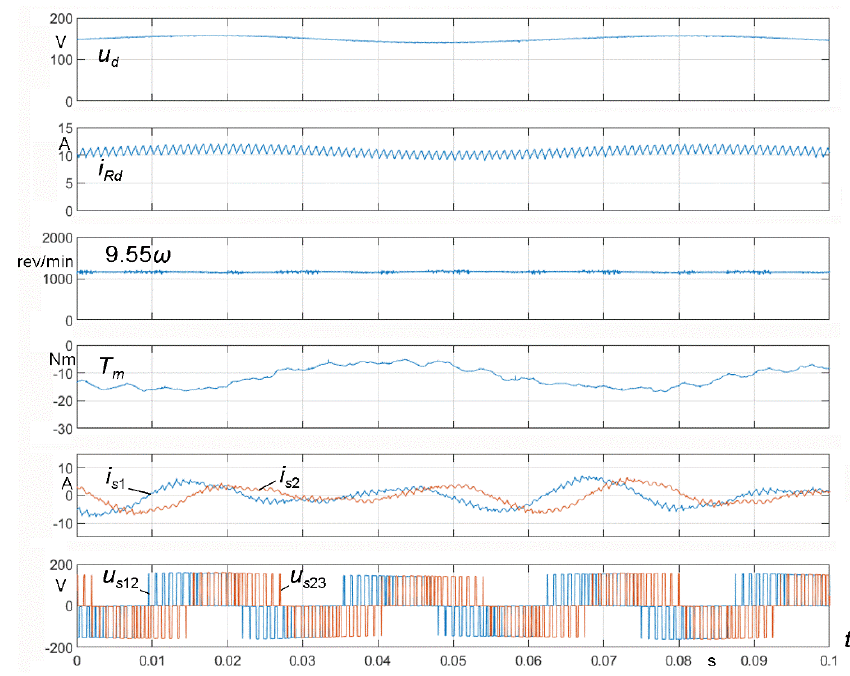
Figure 17. Steady-state waveforms corresponding to case D in Figure 13 at Ω pu = 0.6, m = 2. The work for cases A, B, and C was stable, as the voltage was kept at the set level. The torque T m showed a slight undulation. For A and B, the phase currents were sinusoidal, but, for C (Figure 16), the currents were triangular. The greatest disturbances in the phase and moment currents, as well as the oscillations of the output voltage and current, occurred in case D (Figure 17). The necessary field weakening in this case was obtained with PWM overmodulation. The advantage, however, is that the desired voltage level was obtained with twice the efficiency of m =